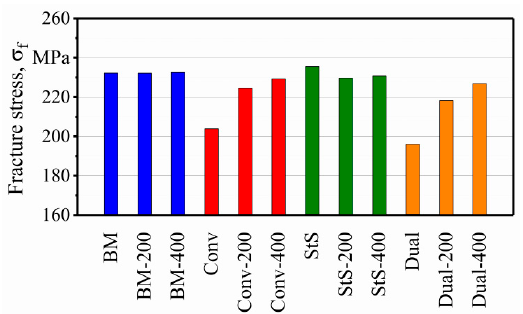
Figure 14. Summary of the effect of the surface finishing process on the base and friction stir welded (FSW) EN AW-5754 specimens.